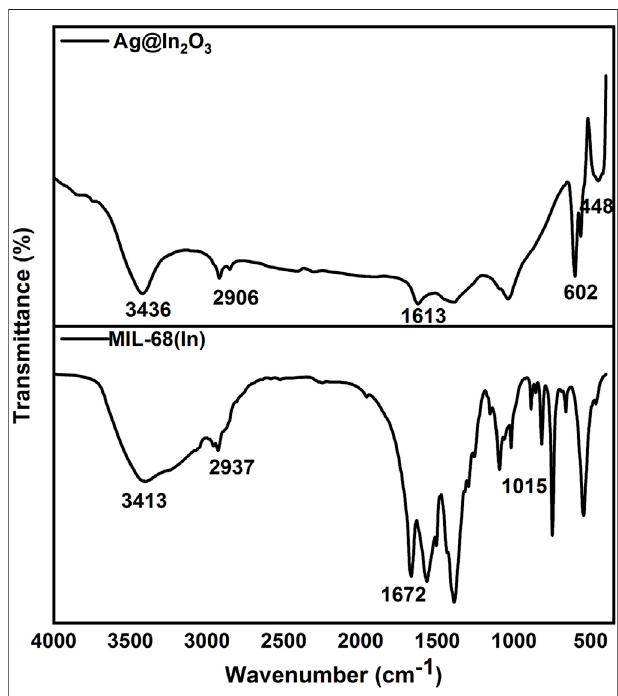
FIGURE 3 | FTIR-spectra of MIL-68(In) and Ag@In 2 O